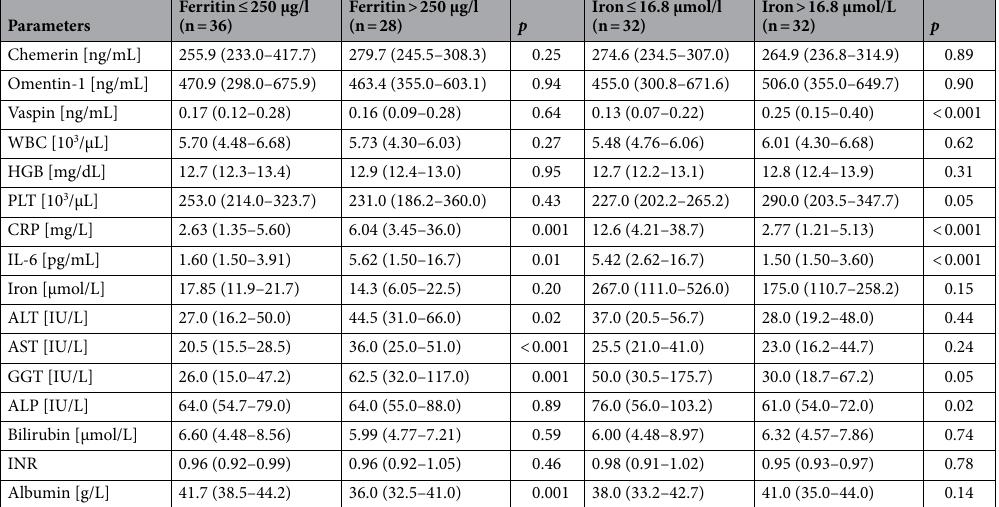
Table 8. Comparison of analyzed parameters between patients with different ferritin as well as iron